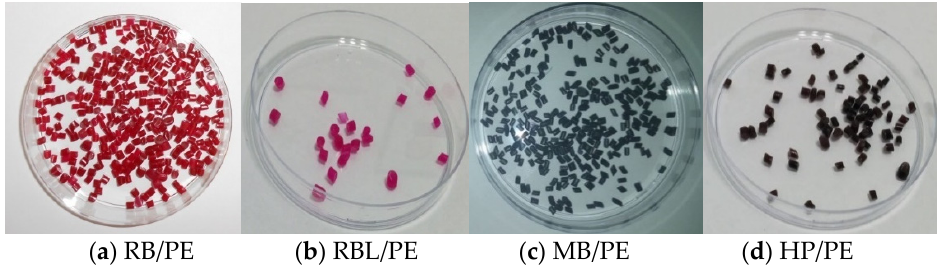
Figure 1. Polyethylene beads containing 1% ( w / w ) PS.